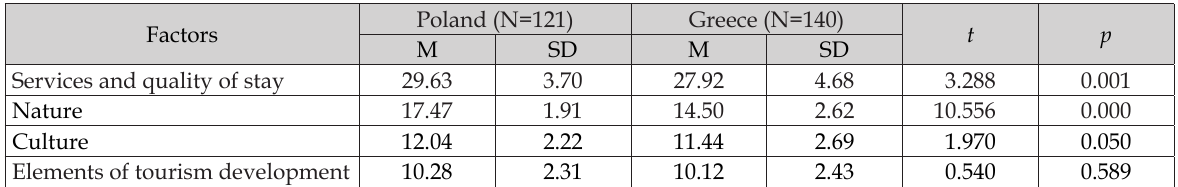
6. Descriptive statistics of t-test for independents samples, by country ( t – t -test, p – significance at the